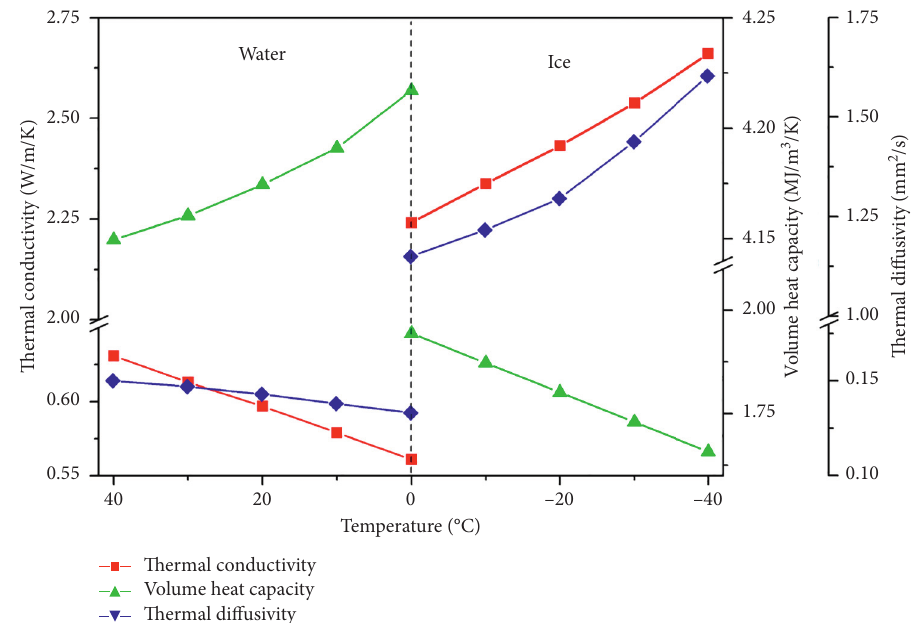
Figure 4: Variations of thermal properties of water and ice with the